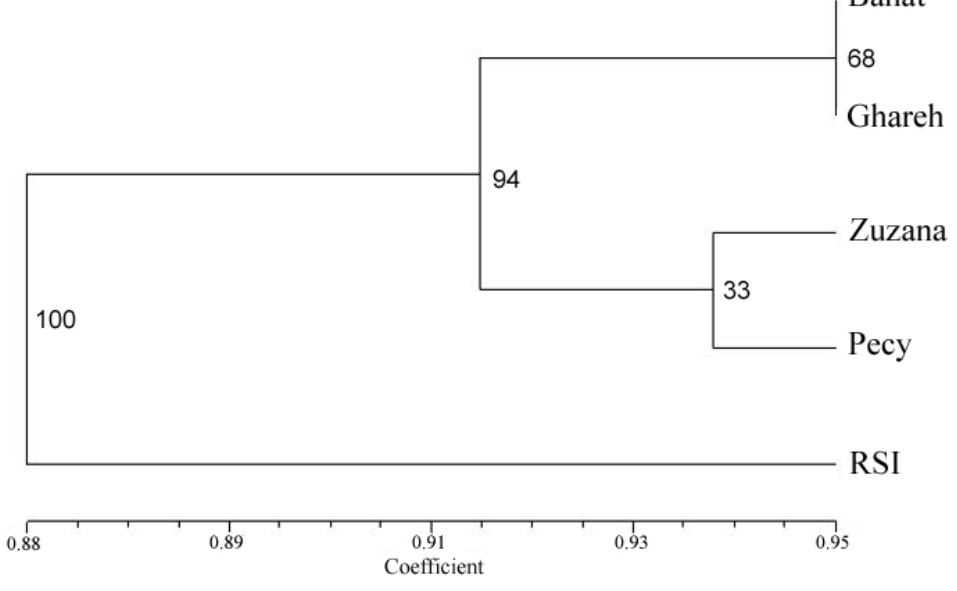
Figure 2. Dendogram of five alfalfa varieties based on unweighted pair group arithmetic mean method cluster analysis of Jaccard’s genetic similarity coefficients. Numbers represent bootstrap confidence limits for 1000